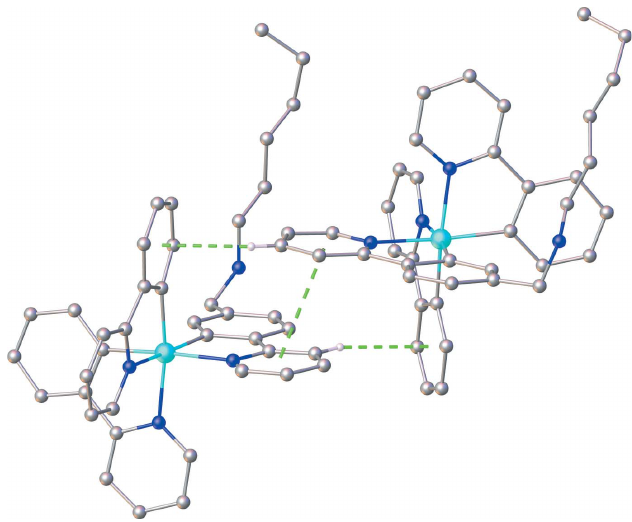
Figure 3 A perspective view showing the parallel fourfold phenyl embrace in the title